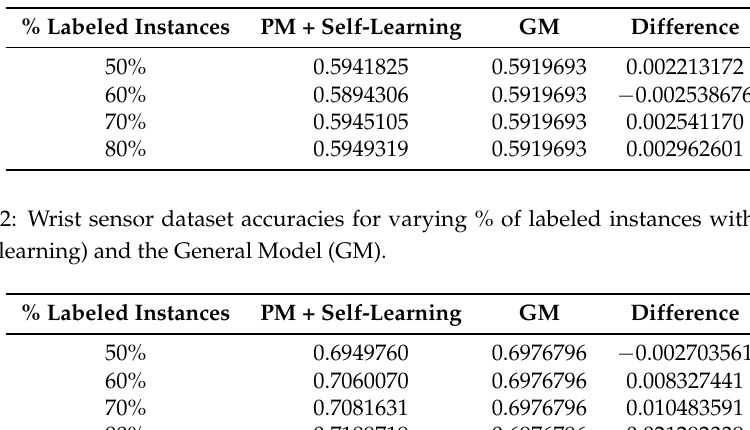
Figure 14. D5: Opportunity dataset bar plot for different % of labeled data with self-learning. Table 6. D1: Chest sensor dataset accuracies for varying % of labeled instances with self-learning (PM + self-learning) and the General Model (GM).